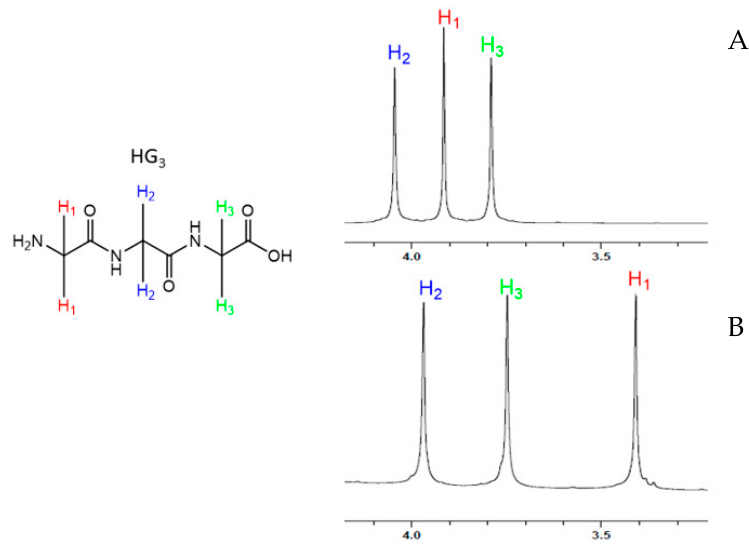
Figure 2. Proton NMR overlay of HG 3 ( A ) and MgG 3 ( B ) showing the observable upfield shifts of all protons and the subsequent change in proton splitting pattern. Full spectra in Supplemental Figure S7.